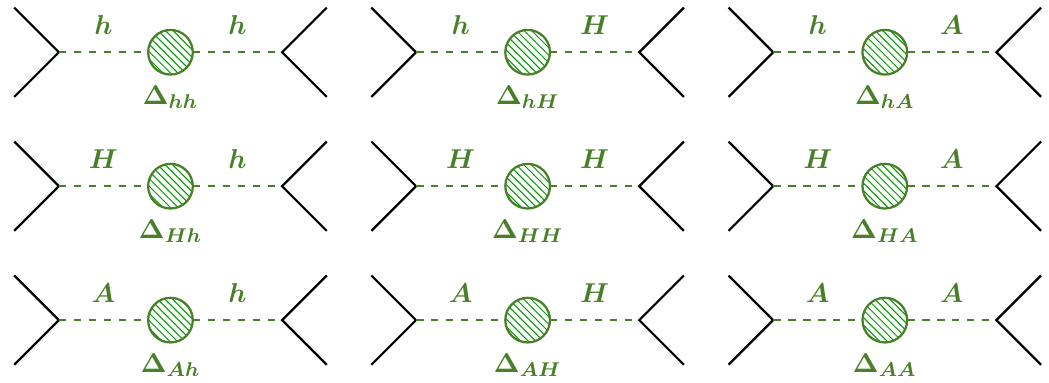
Figure 3 . Contributions from the full mixing propagators (cid:1) ij ( p 2 ) for i; j = h; H; A to a generic amplitude (cf. ref. [13]). If the ^ Z -factor approach is applied, each of the 9 full propagators needs to be approximated by the sum of the three corresponding Breit-Wigner diagrams as shown in (cid:12)gure 2.